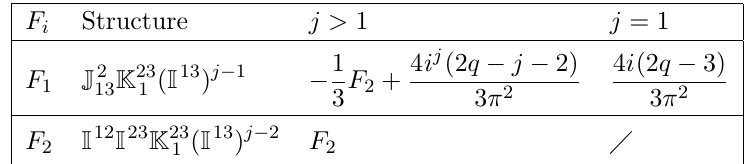
Table 9 . Ward identities of the supersymmetry current for the correlator spin (0 ; 1 ( j 1)). 2 (cid:0)